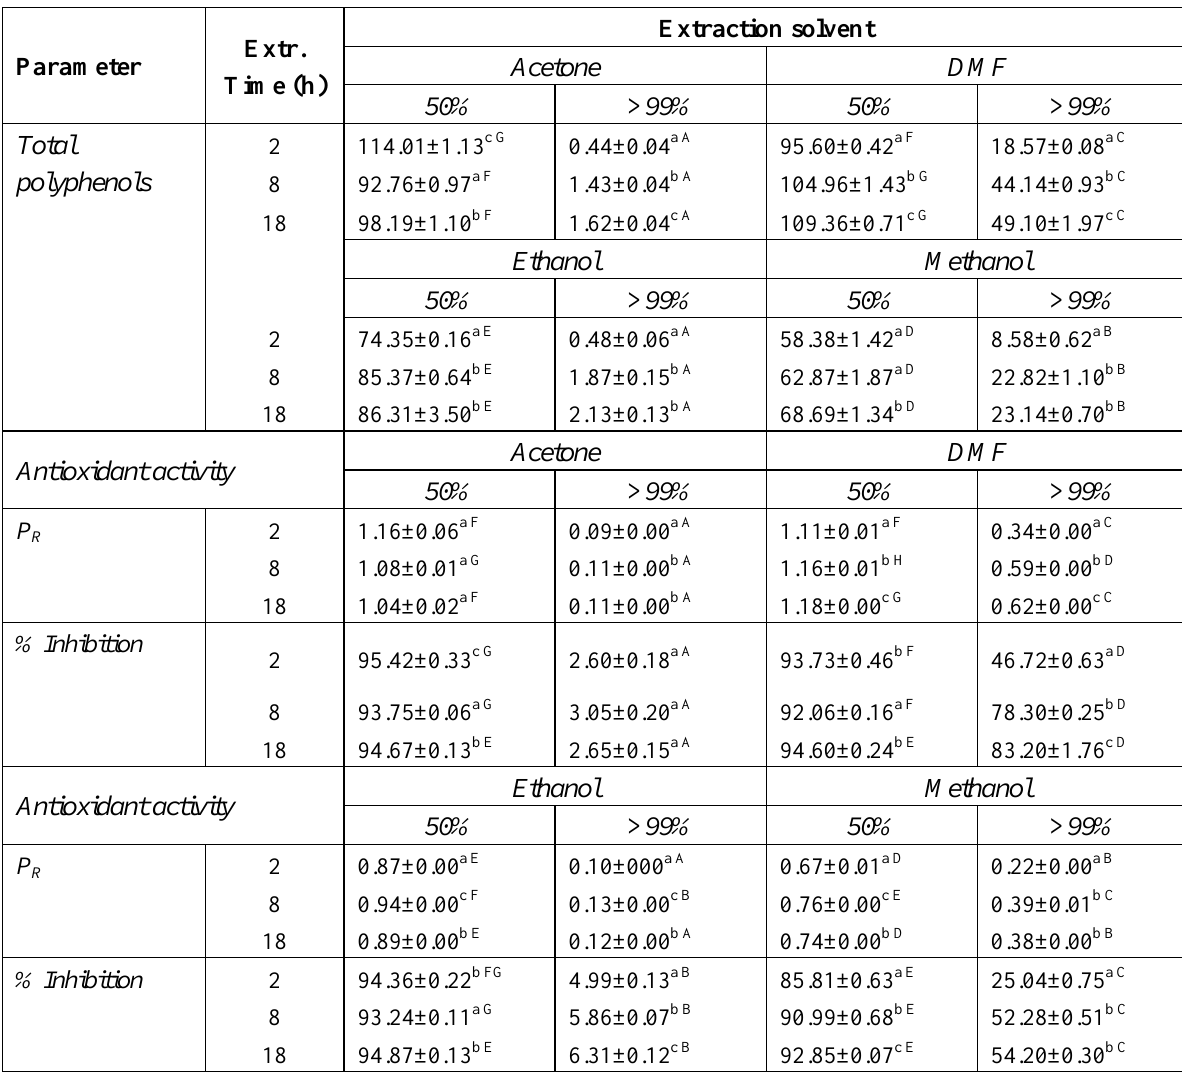
Table 1. Effect of different solvents and extraction times on total polyphenol content